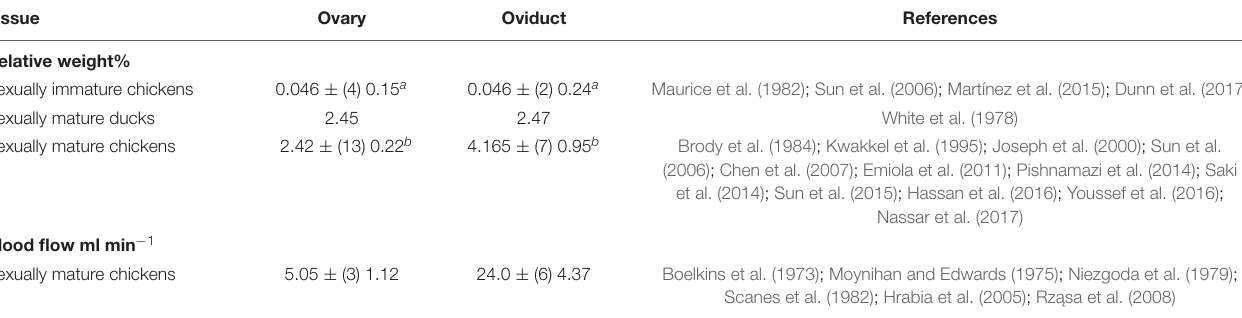
TABLE 7 | Relative weights of the ovary and oviduct in ducks and chickens together with blood flow [data is shown as mean ± (number of studies) SEM]. Tissue Ovary